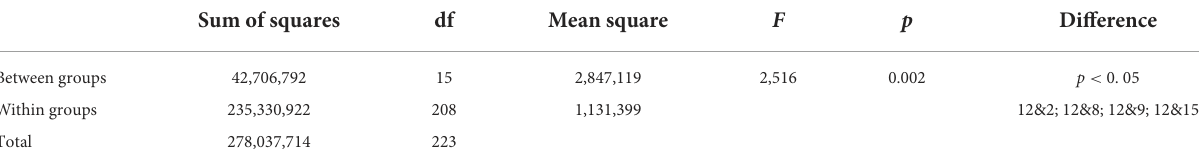
TABLE 2 Innovation and entrepreneurialism difference between the units of the universities Anova test. Sum of squares df Mean square F p Difference Between groups 42,706,792 15 2,847,119 2,516 0.002 p < 0. 05 Within groups 235,330,922